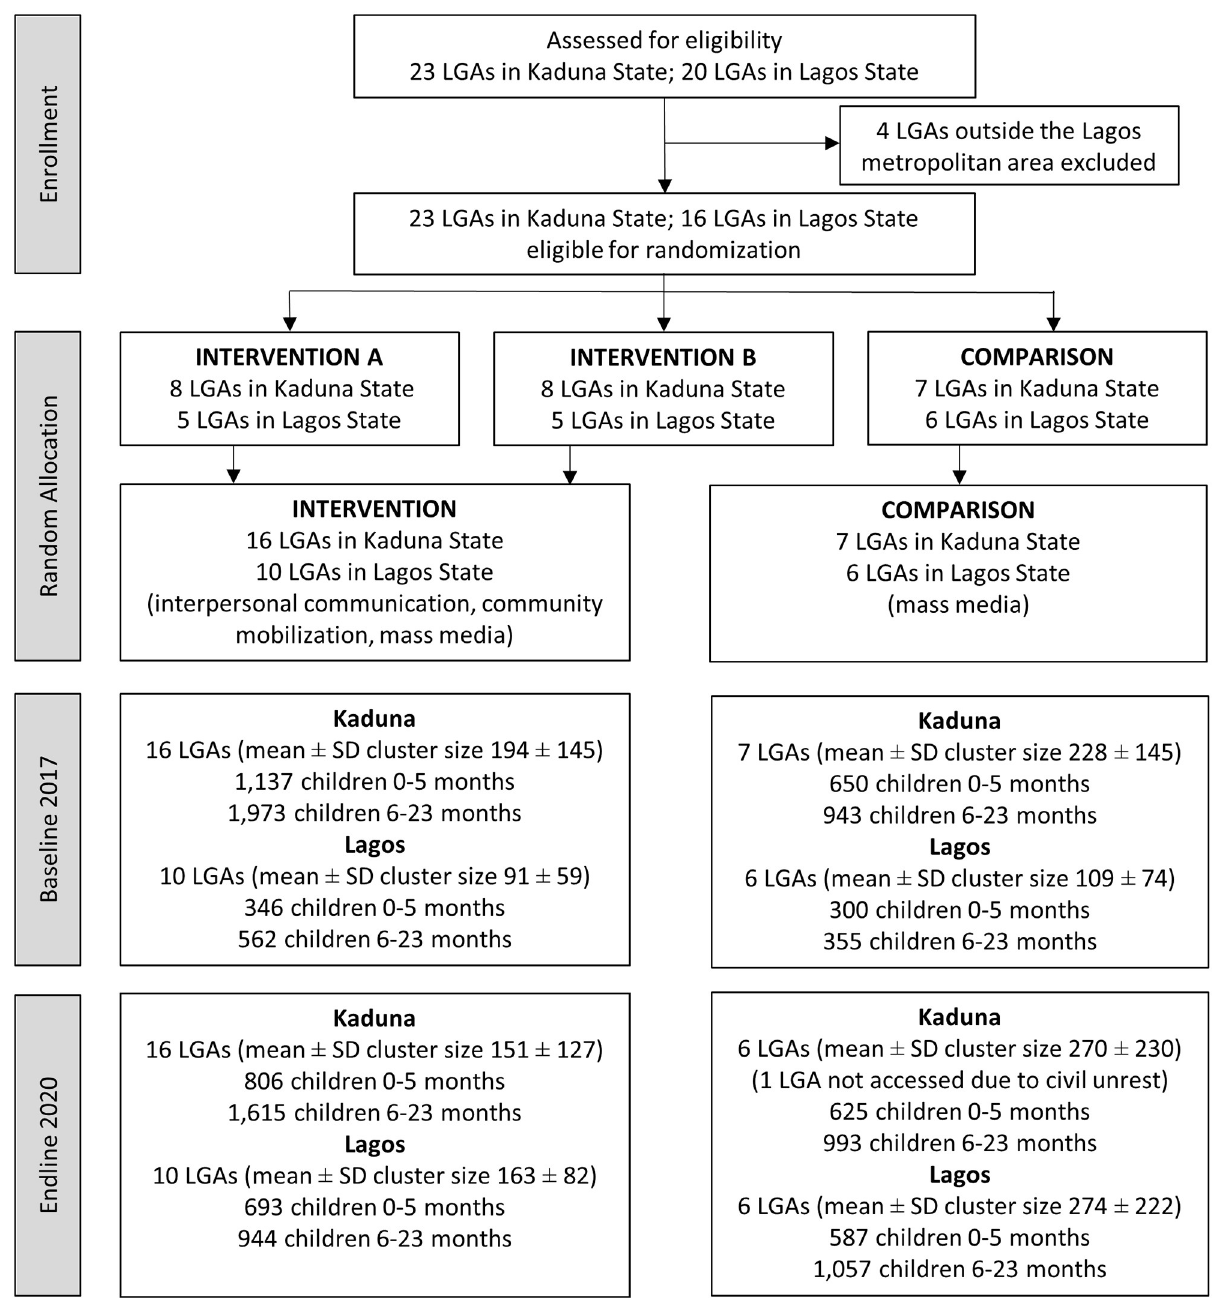
Fig 1. Consort diagram for the Alive & Thrive Nigeria impact